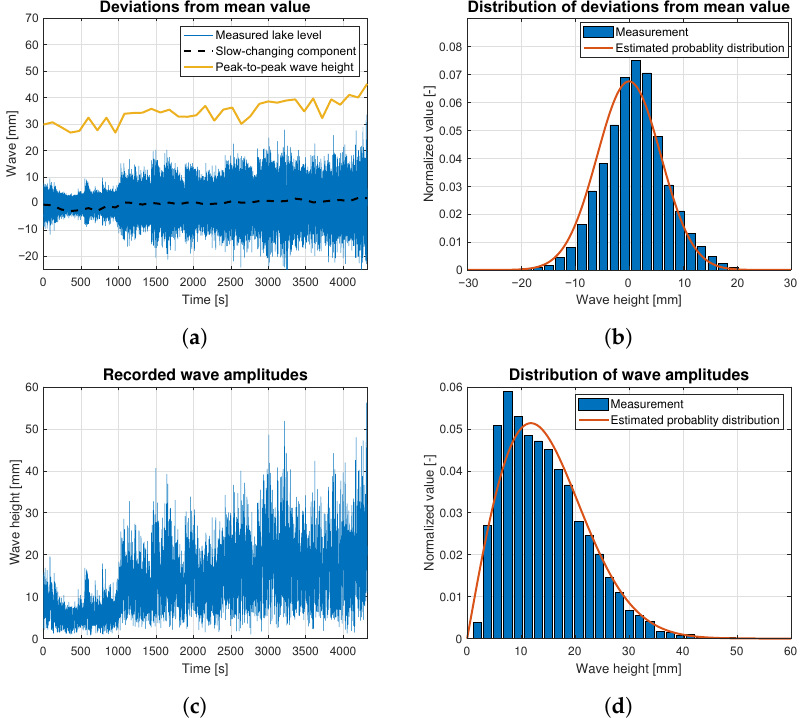
Figure 12. Statistical analysis of the wave height corresponding to 6 BFT wind force in ship scale: ( a ) deviations from the slow-changing component; ( b ) probability distribution of wave height deviations from mean value; ( c ) recorded wave amplitudes; ( d ) probability distribution of wave height amplitudes.